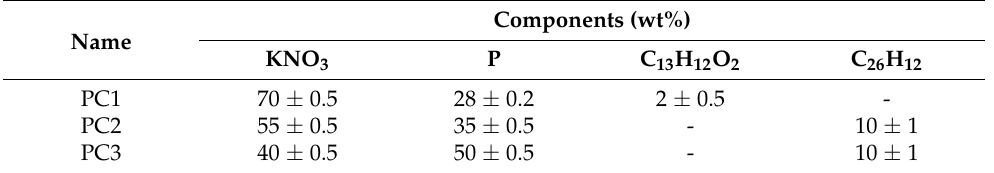
Table 1. Codes and composition of the primary components.